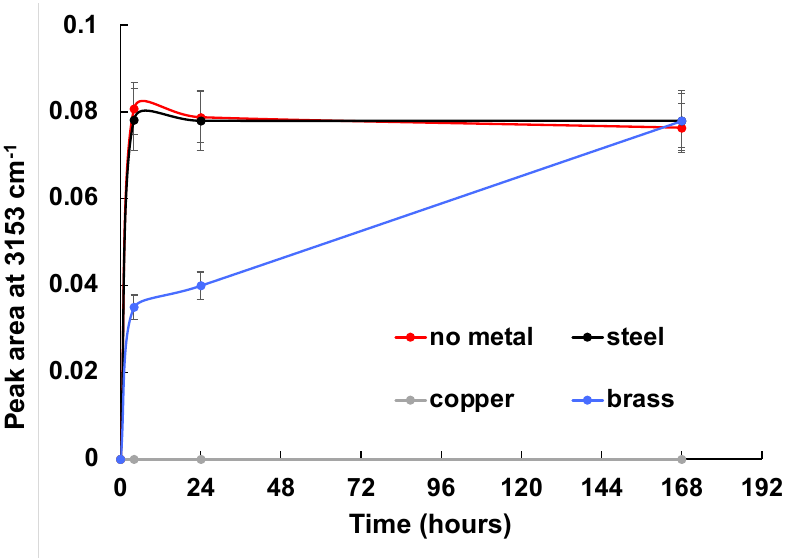
Figure 4. Area of the peak at 3153 cm − 1 in the IL spectra after 4, 24 and 168 h of thermal treatment with or without metal plates as a function of incubation time.